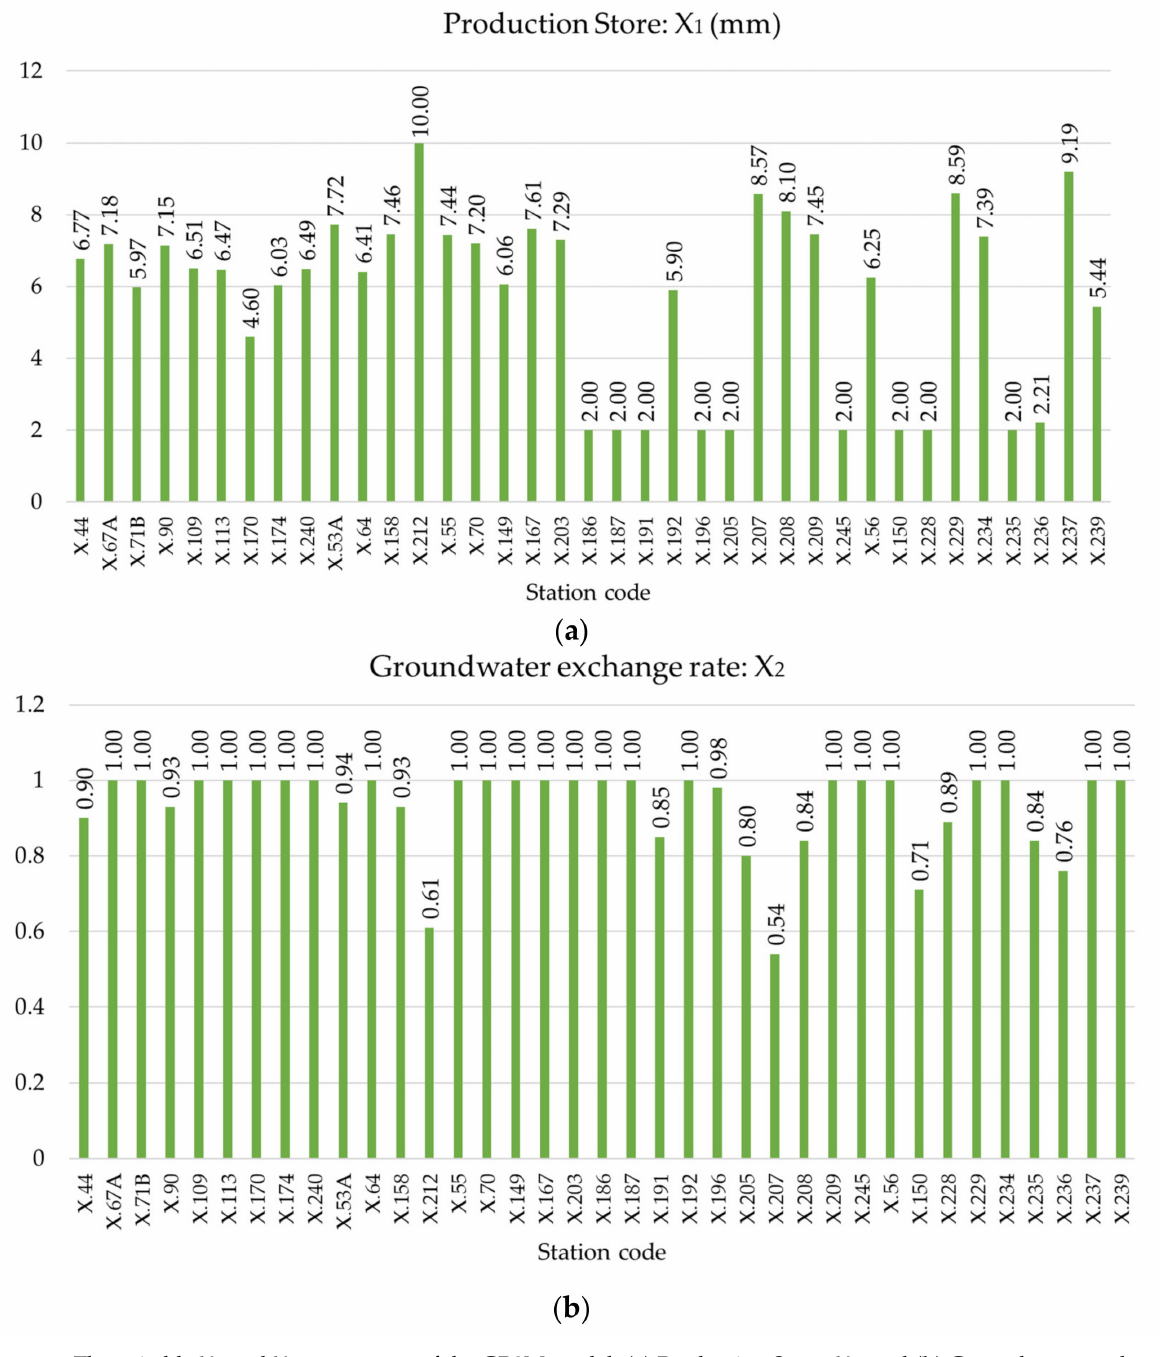
Figure 5. The suitable X 1 and X 2 parameters of the GR2M model: ( a ) Production Store: X 1 , and ( b ) Groundwater exchange rate: X 2